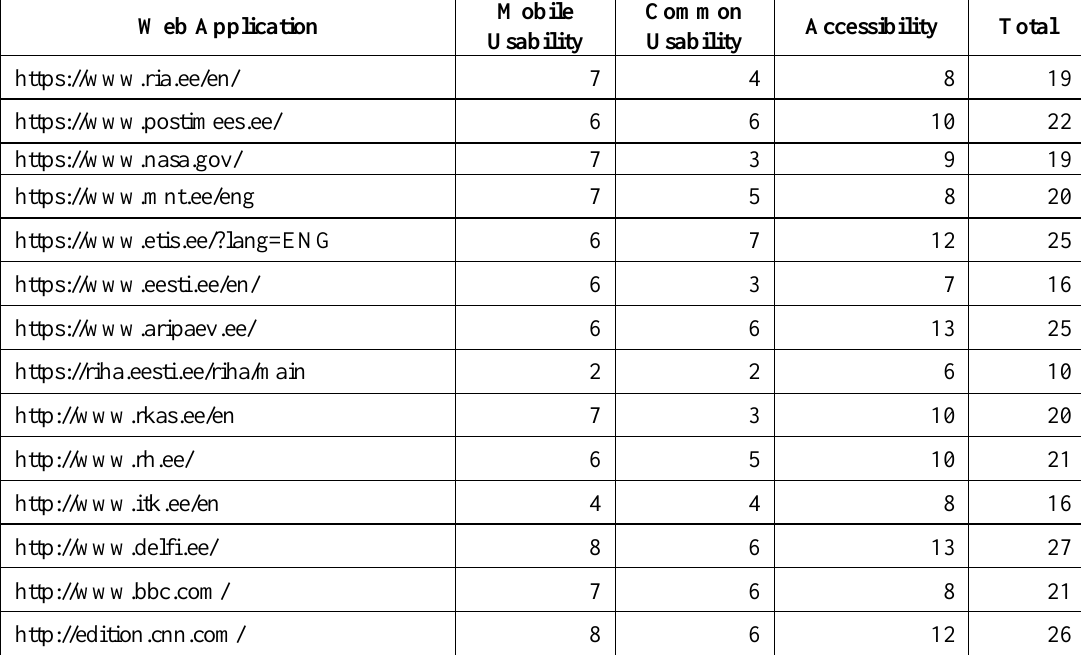
Table 3 . Results of usability evaluation executed on various WUIs Web Application